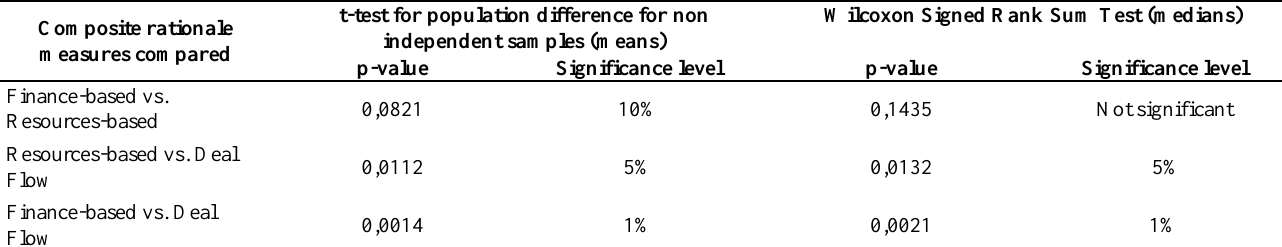
Table 8: Test for differences in the means and medians of the non-syndication composite rationale variables t-test for population difference for